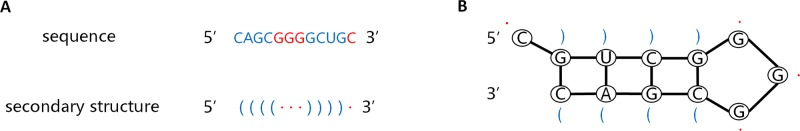
Sequence of pre-miRNA and corresponding secondary structures predicted by RNAfold. (A) Sequence of pre-miRNA and secondary structures described by dot-bracket notation. (B) Secondary structure of the given sequence.